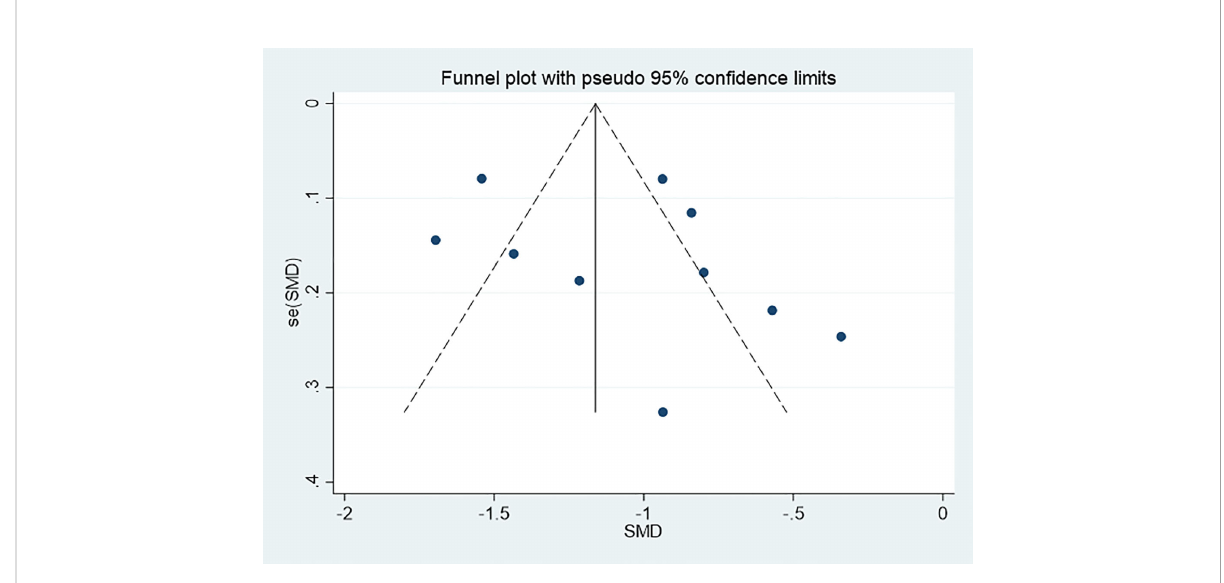
FIGURE 11 Funnel plot for assessing publication